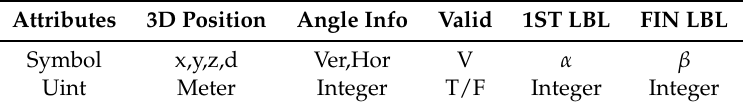
Table 1. Single point structure.